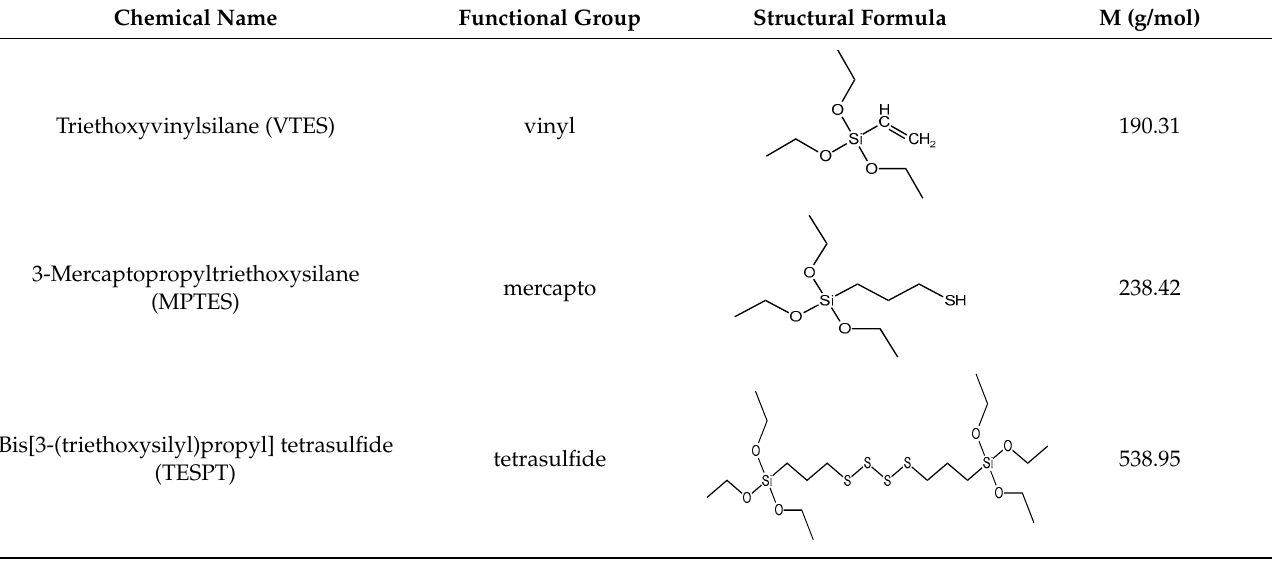
Table 1. Structure and chemical characteristics of silane molecules.